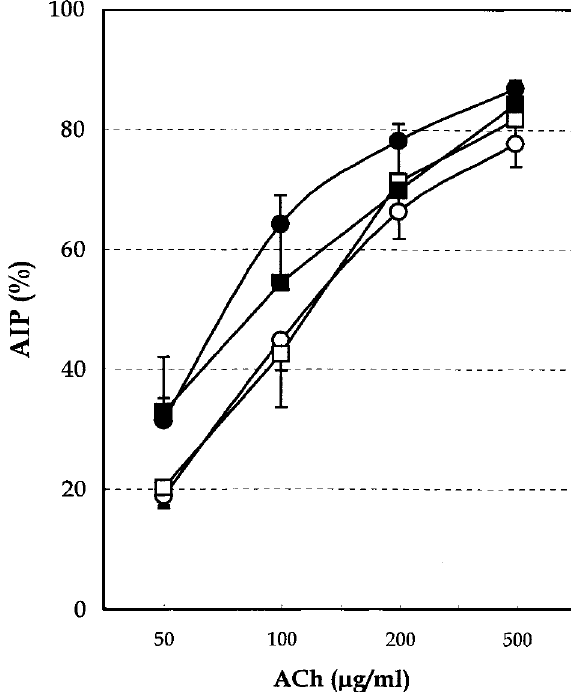
FIG. 4. Influence of zaprinast (30mg/kg) on cumulative dose± response curve for acetylcholine (50, 100, 200 and 500 m g/ml) in anaesthetized guinea-pigs, 24h after ovalbumin chal- lenge. Sensitized guinea-pigs were treated orally with zapri- nast (30mg/kg), 24 and 3h before the antigen challenge (OA) or saline exposure (SAL). Symbols represent control with ( h ) or without ( s ) zaprinast and after antigen challenge with ( j ) or without ( d ) zaprinast ( n =5± 20). No significant difference is noted between OA and OA+zaprinast. Significant difference between SAL+Ro 20± 1724 and zaprinast+OA is P